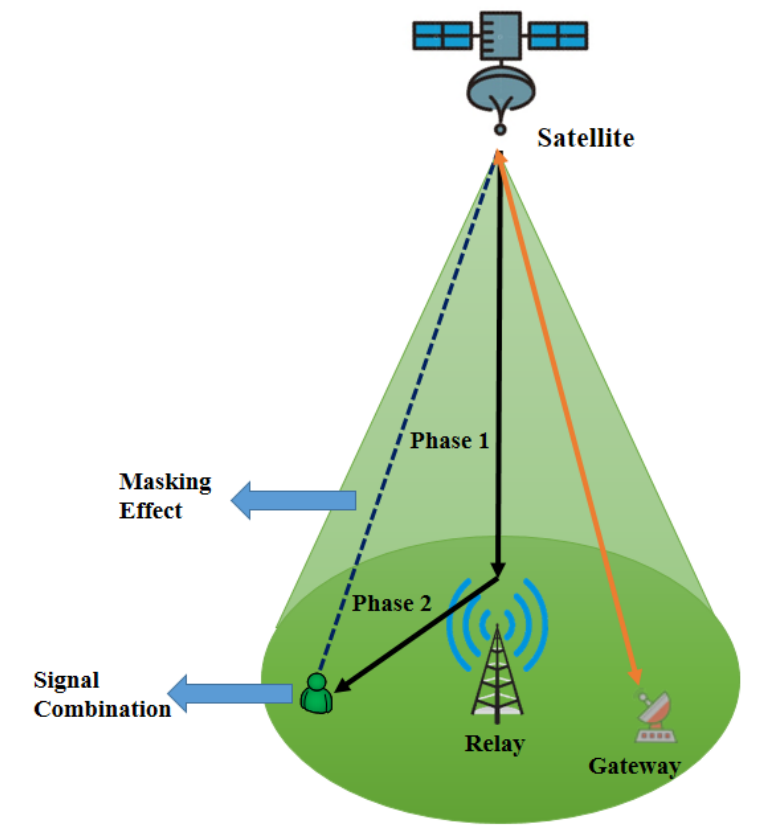
Figure 4. HSTN with relaying